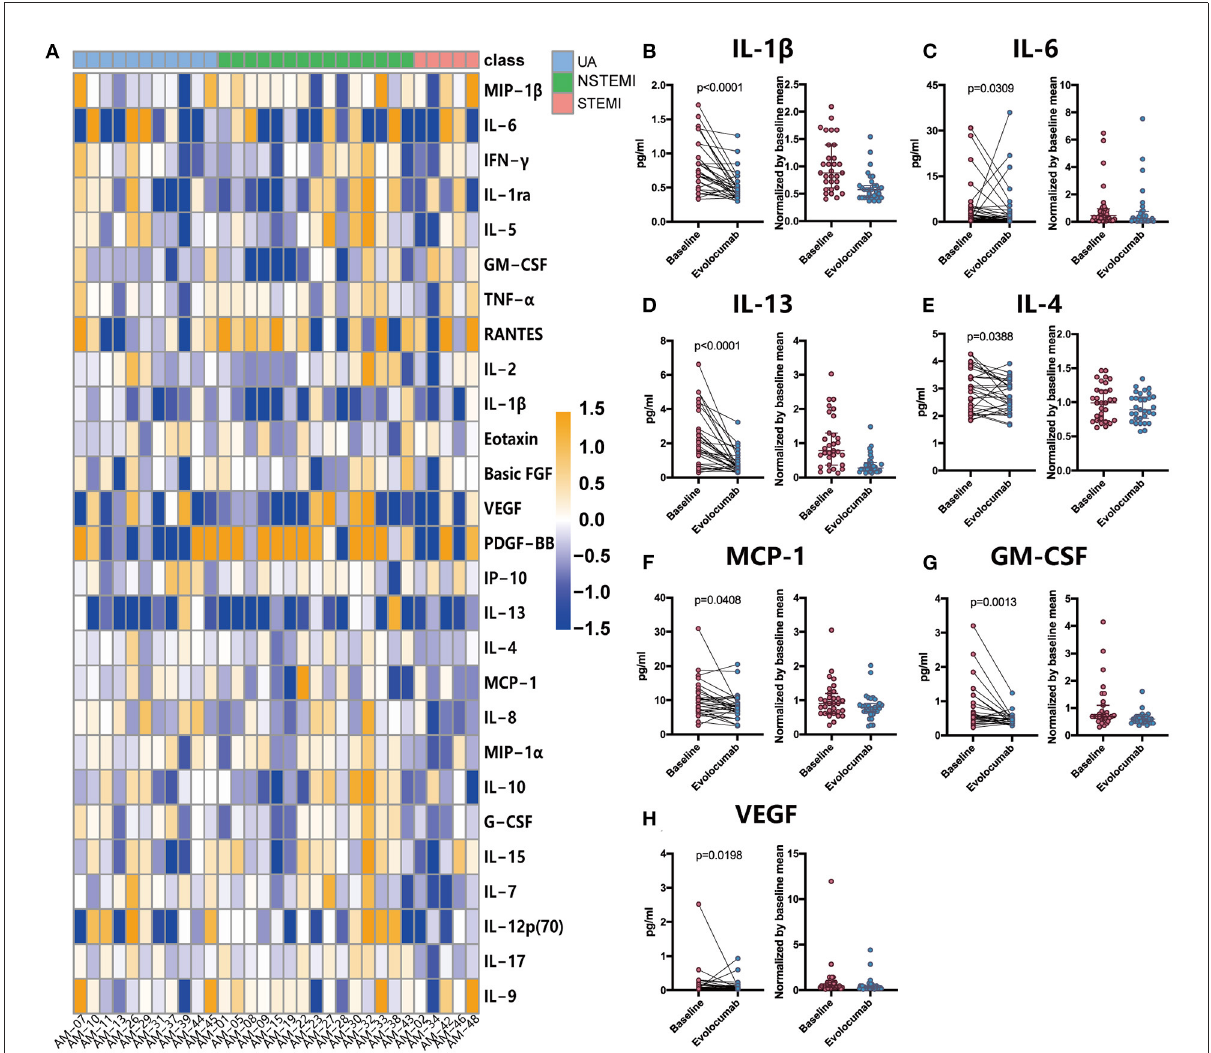
FIGURE4 Comparison of plasma cytokine and chemokine levels between baseline and 72h post-evolocumab administration in patients with ACS. Cytokine and chemokine levels were measured in 31 ACS patients using Luminex assay. (A) Heat map of log2 fold changes over the average baseline levels of 27 analytes. (B–H) Differentially expressed cytokines and chemokines. Differences were tested using Wilcoxon matched-pairs signed rank test. Data are shown as actual concentrations (left) or medians with interquartile ranges of values normalized by baseline mean (right). UA, unstable angina; NSTEMI, non-ST-elevation myocardial infarction; STEMI, ST-elevation myocardial